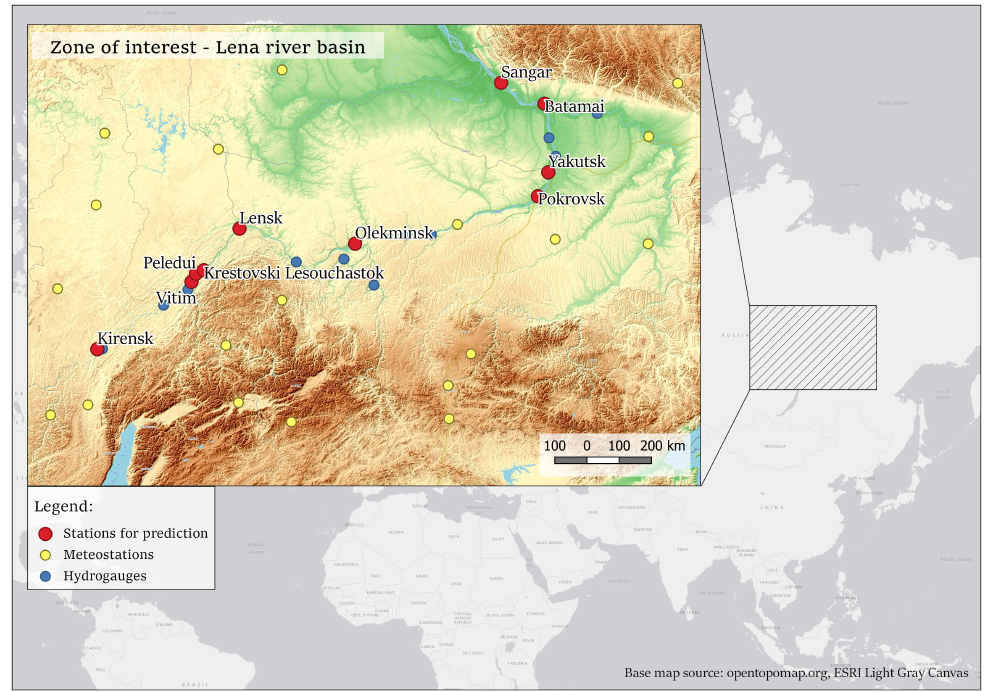
Figure 1. Spatial position of observation stations and Lena River